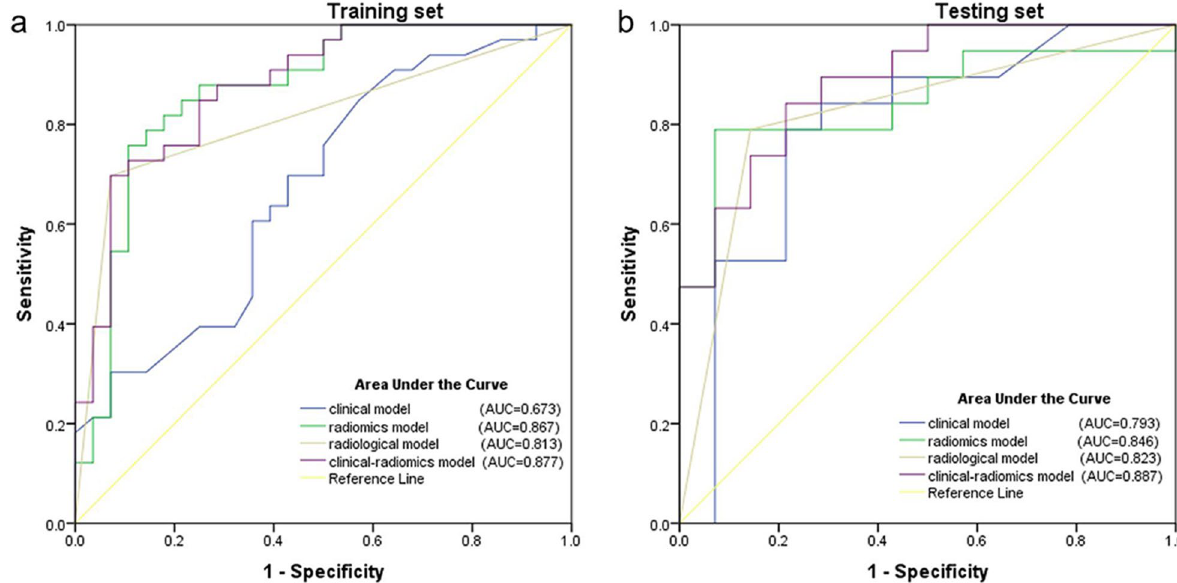
Fig. 5 The ROC curves of the clinical (age and menopause), radiomics, radiological, and clinical–radiomics models for staging CC in the training ( a ) and the testing cohorts ( b ). The clinical–radiomics model yielded the highest AUCs for staging CC in the training cohort (AUC testing cohort (AUC 0.887) =